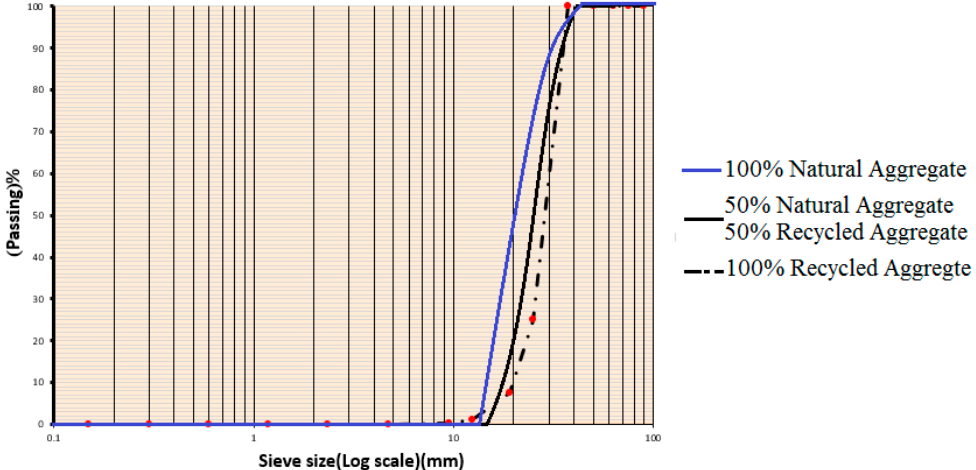
Figure 7. Grading curve of the aggregates employed in the current investigation. Table 1. Physical and chemical properties of RCA and NCA.